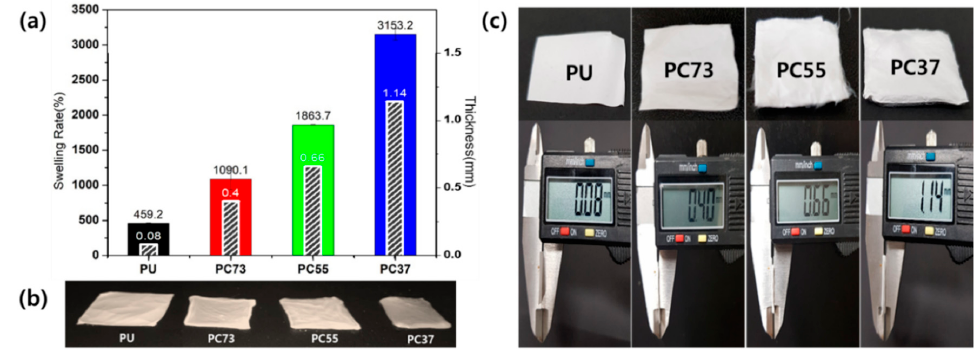
Figure 2. ( a ) Swelling behavior and thickness of PU and composite nanofibrous mats. ( b ) Optical image of the samples after swelling test. ( c ) The lyophilized PU, PC73, PC55, and PC37 membranes and respective